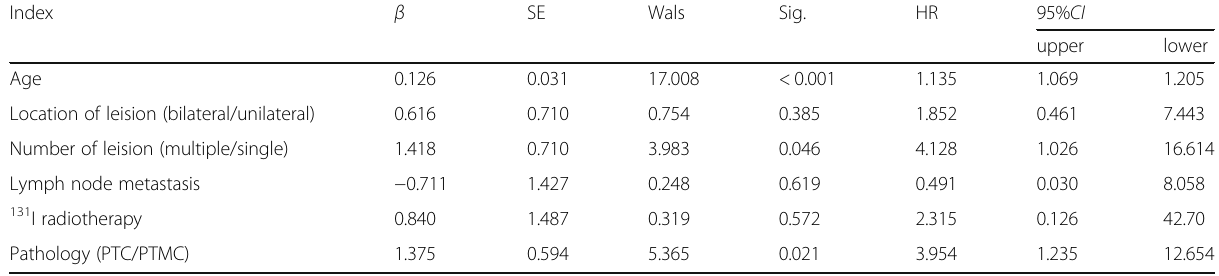
Table 5 Logistic regression analyses between BRAF V600E mutation alone and double mutant group